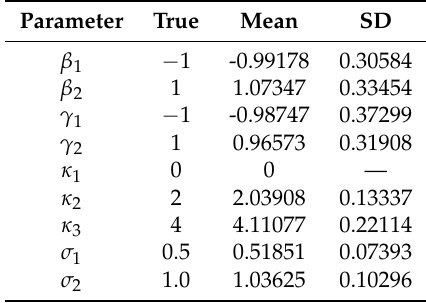
Table 2. Simulated data: means and standard deviations (SD) of the posterior estimates of the model parameters based on the 100 generated